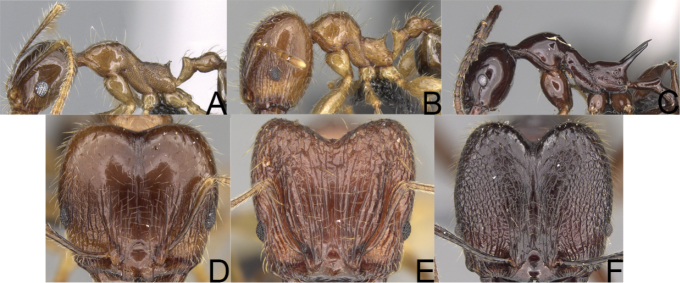
Pheidole
megacephala (Fabricius), minor worker, profile (A) (Shannon Hartman). Major worker, profile (B), head (D). Pheidole
longispinosa Forel minor worker, profile (C). Pheidole
ferruginea sp. nov. major worker, head (E). Pheidole
cf.
sikorae major worker, head (F).